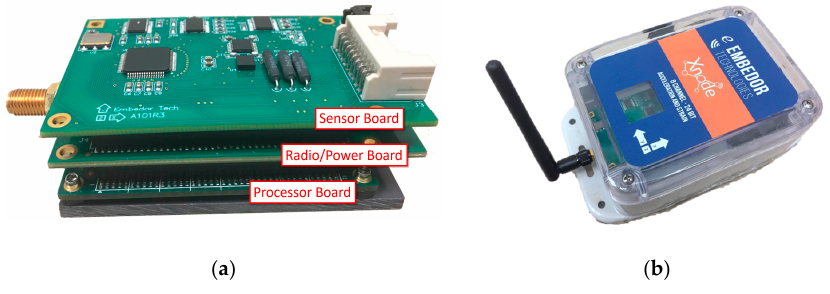
Figure 2. Xnode Smart Sensor: ( a ) 3-board stack; ( b ) Enclosure.